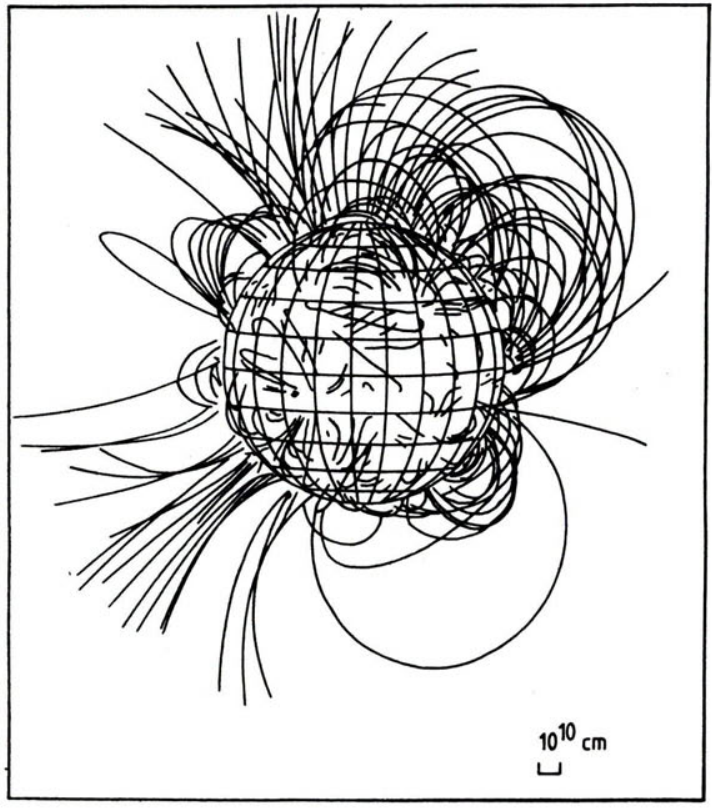
Fig. 9. Coronal magnetic field approximated by the field of dipols in the spherical system of coordinates.